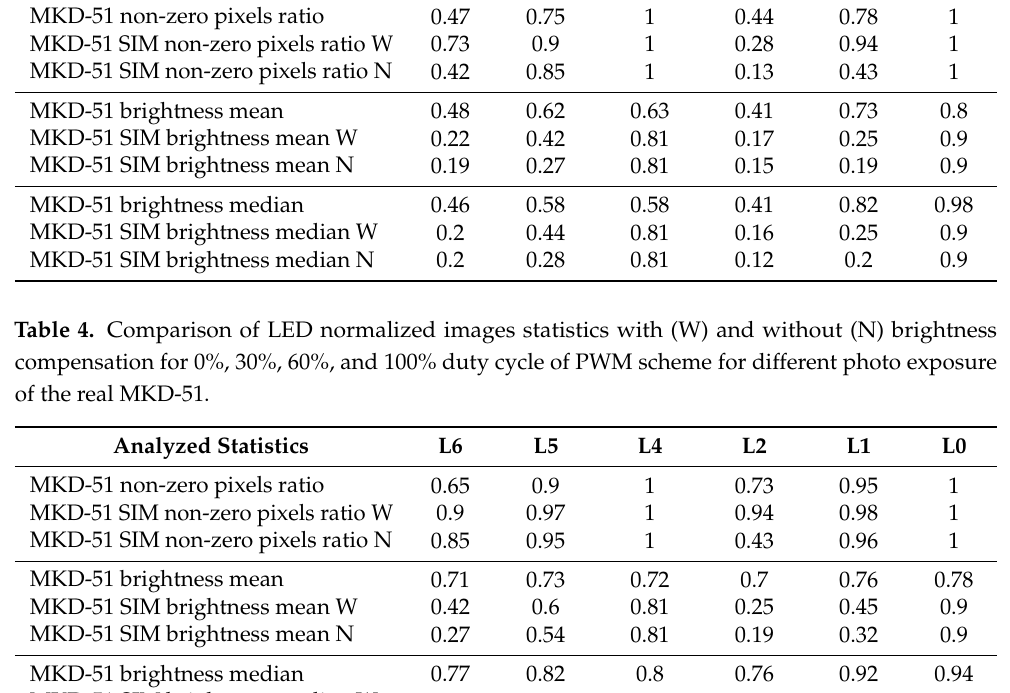
MKD-51 brightness